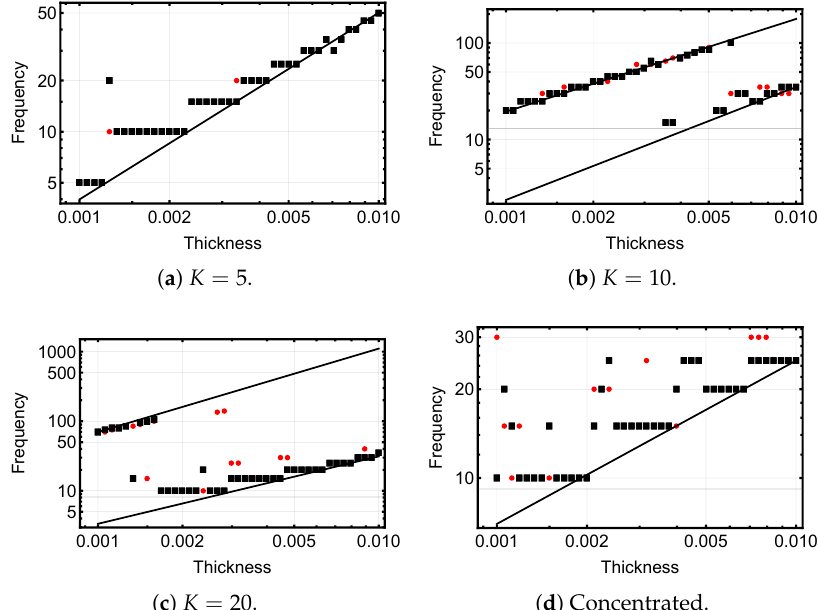
Figure 8. Most energetic response. Observed frequency as a function of the thickness. Red colour indicates low-rank approximation if there is a discrepancy. All trend lines for Fourier loads have a rate ∼ 1; for the concentrated load, the rate is ∼ 1/2.